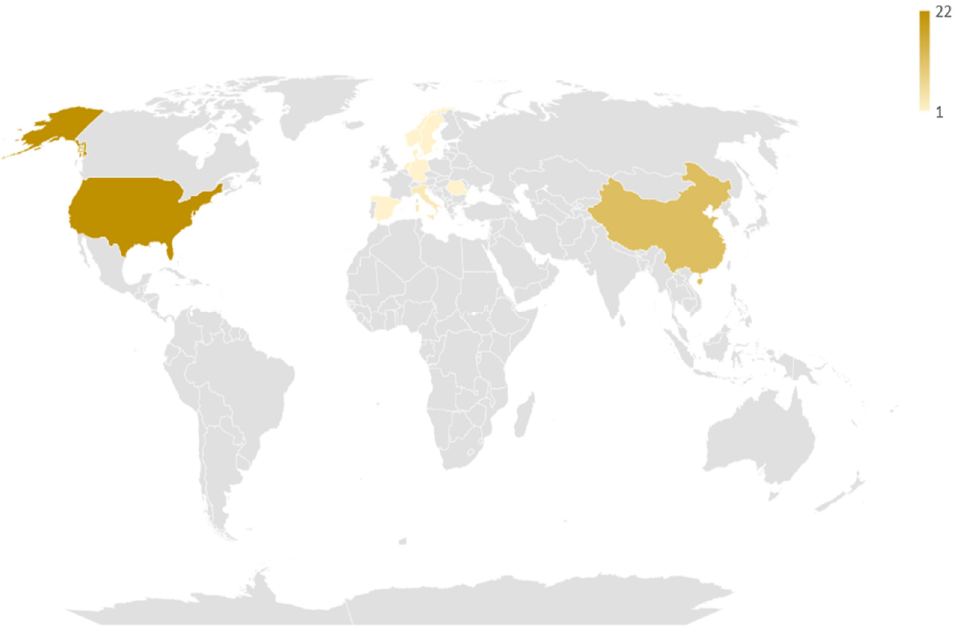
Figure 2. Geographic distribution of the studies included in the review. The darker the hue, the larger the number of studies coming from this particular country.